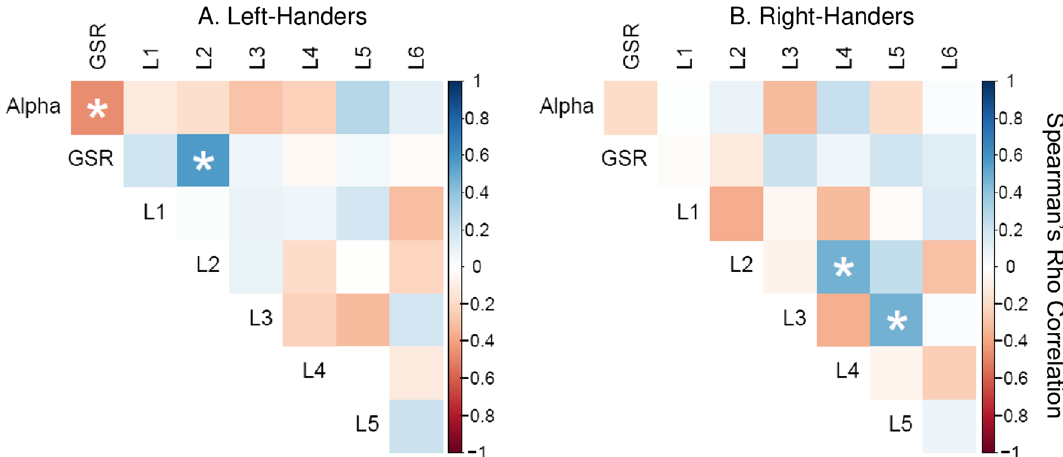
Figure 5. Spearman’s Rho correlations between physiological alertness (GSR and alpha) and reaction time to all six locations for left-handers ( A ) and right-handers ( B ). Correlations reaching significance ( p < .05) are highlighted. L1 = location 1. Positive values for RT indicate slower RT in the second half than first half of drive (i.e., time-on-task), positive GSR values indicate higher SNS derived alertness with time-on-task, and positive alpha indicates higher alpha power (indicating lower alertness) with